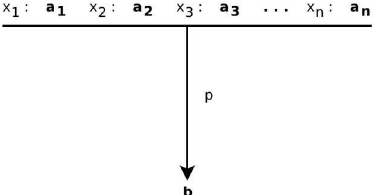
Figure 2. Structure of a linked argument with initial strengths x 1 , . . . , x n and polarity p . Removing a link will result in a much less conclusive or an inconclusive